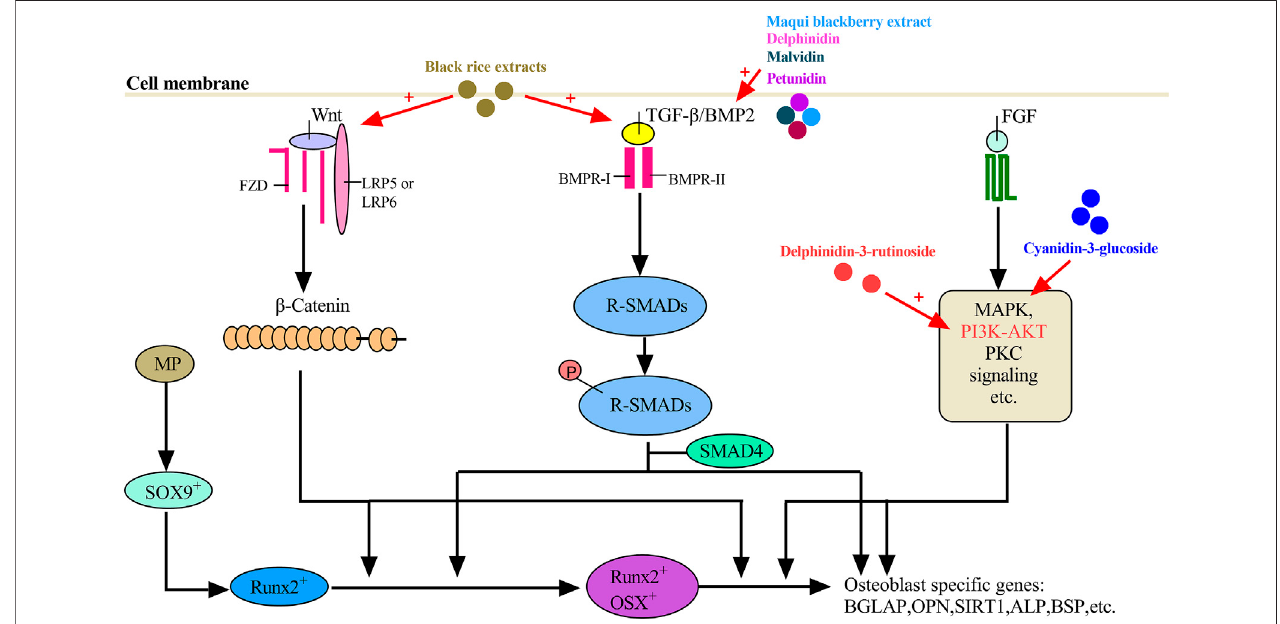
FIGURE 1 | A proposed working model for the promotion of anthocyanins on osteogenesis.